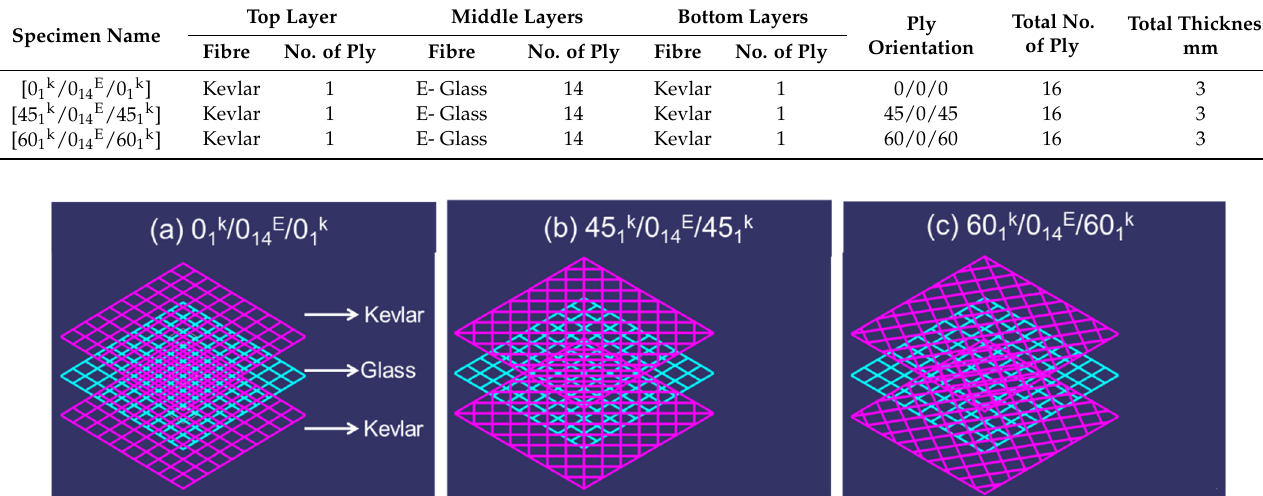
Figure 1. Schematics of the developed composite laminates.